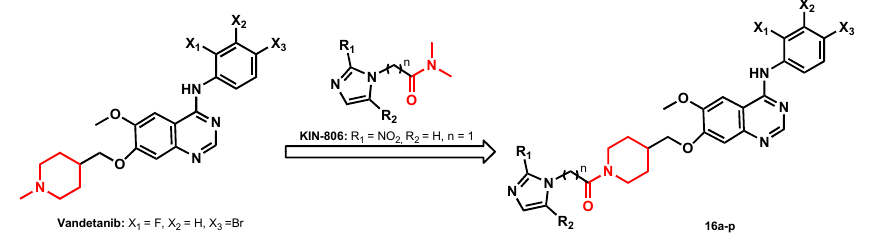
Figure 1. Structures of vandetanib, KIN-806, and target compounds.